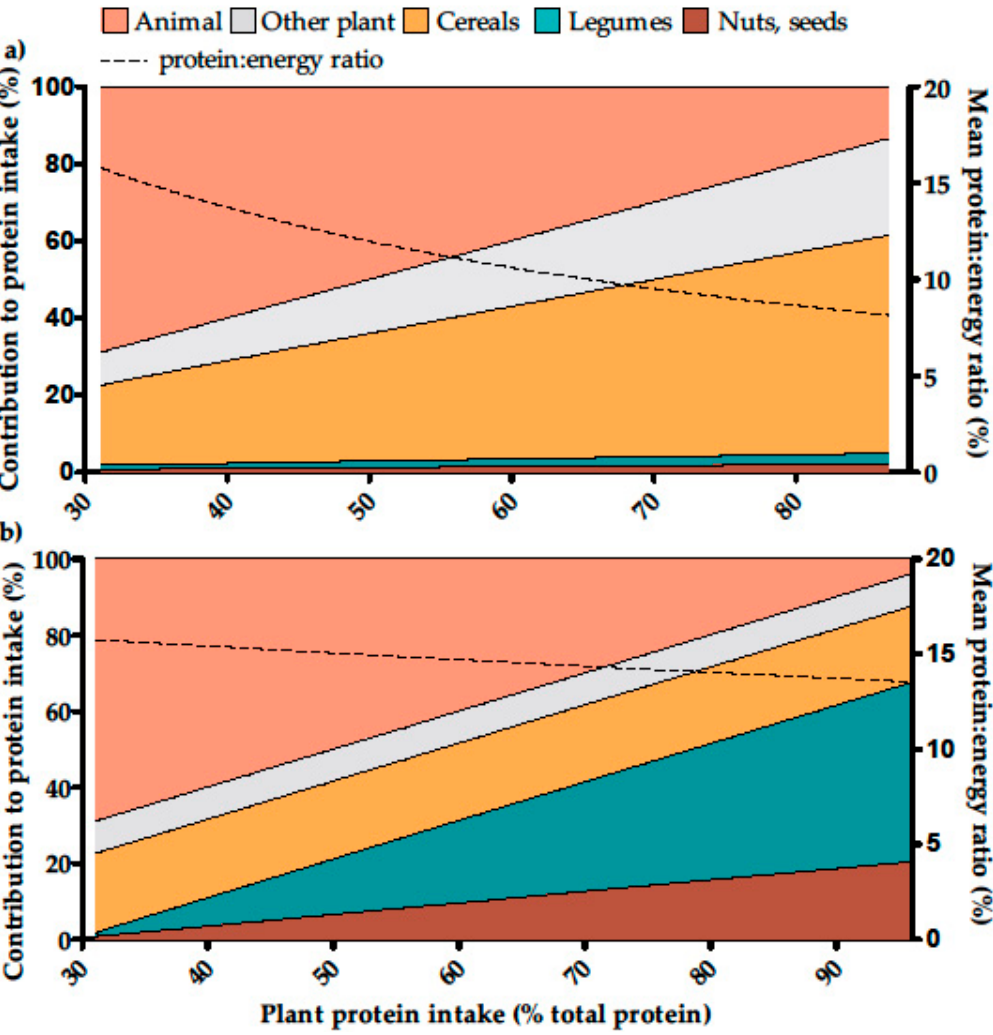
Figure 1. Contribution of animal protein and various plant sources (left axis) and protein:energy ratio (right axis) in the energy adjusted models of substitution of animal protein for plant foods in the French adult population (INCA2 study, n = 1678). ( a ) Animal protein was gradually substituted by the same amount of energy (without alcohol) from plant foods according to the current pattern of consumption in individuals (model A); ( b ) Animal protein was gradually substituted by the same amount of energy (without alcohol) from a mixture of legumes, nuts and seeds (model B). Intermediate models between A and B, i.e., models using 20%, 40%, 60% and 80% of a mixture of legumes, nuts and seeds in the combination used for the substitution are not shown. The highest plant protein level was not 100% due to the intake of mixed foods with both animal and plant protein sources.